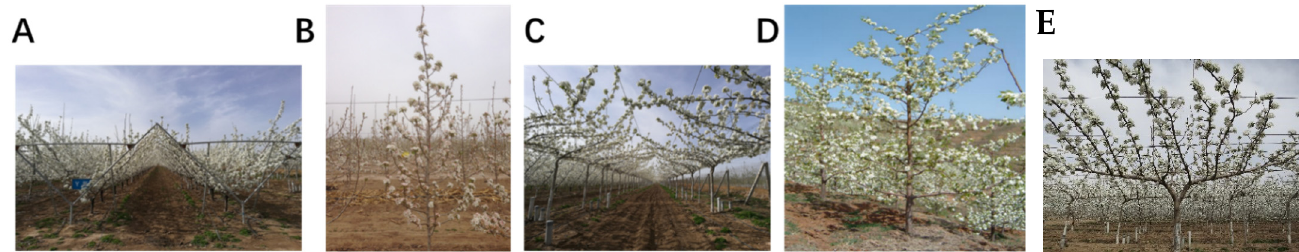
Figure 1. Different shapes of Zaosu pear trees. ( A ) Y ‐ shaped; ( B ) trunk; ( C ) single ‐ arm; ( D ) spindle; ( E ) double ‐ arm. ( E )